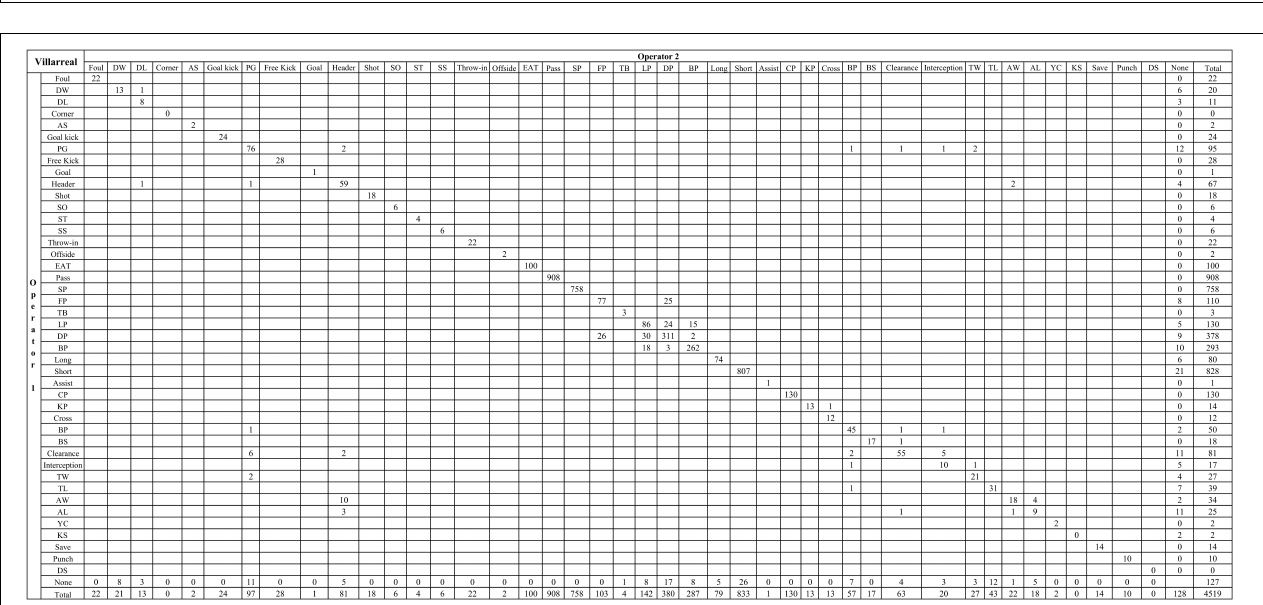
FIGURE 2 | Frequency of Real Madrid’s events recorded by the two independent operators in two collections. DW, dribble won; DL, dribble lost; AS, attacking shift; PG, possession gained; SO, shots off target; ST, shot on target; SS, shot saved; EAT, enter into attacking third; SP, successful pass; FP, forward pass; TB, through ball; LP, lateral pass; DP, diagonal pass; BP, backward pass; CP, consecutive pass; KP, key pass; BP, blocked pass; BS, blocked shot; TW, tackle won; TL, tackle lost; AW, aerial won; AL, aerial lost; YC, yellow card; KS, keeper sweeper; DS, deflected save.